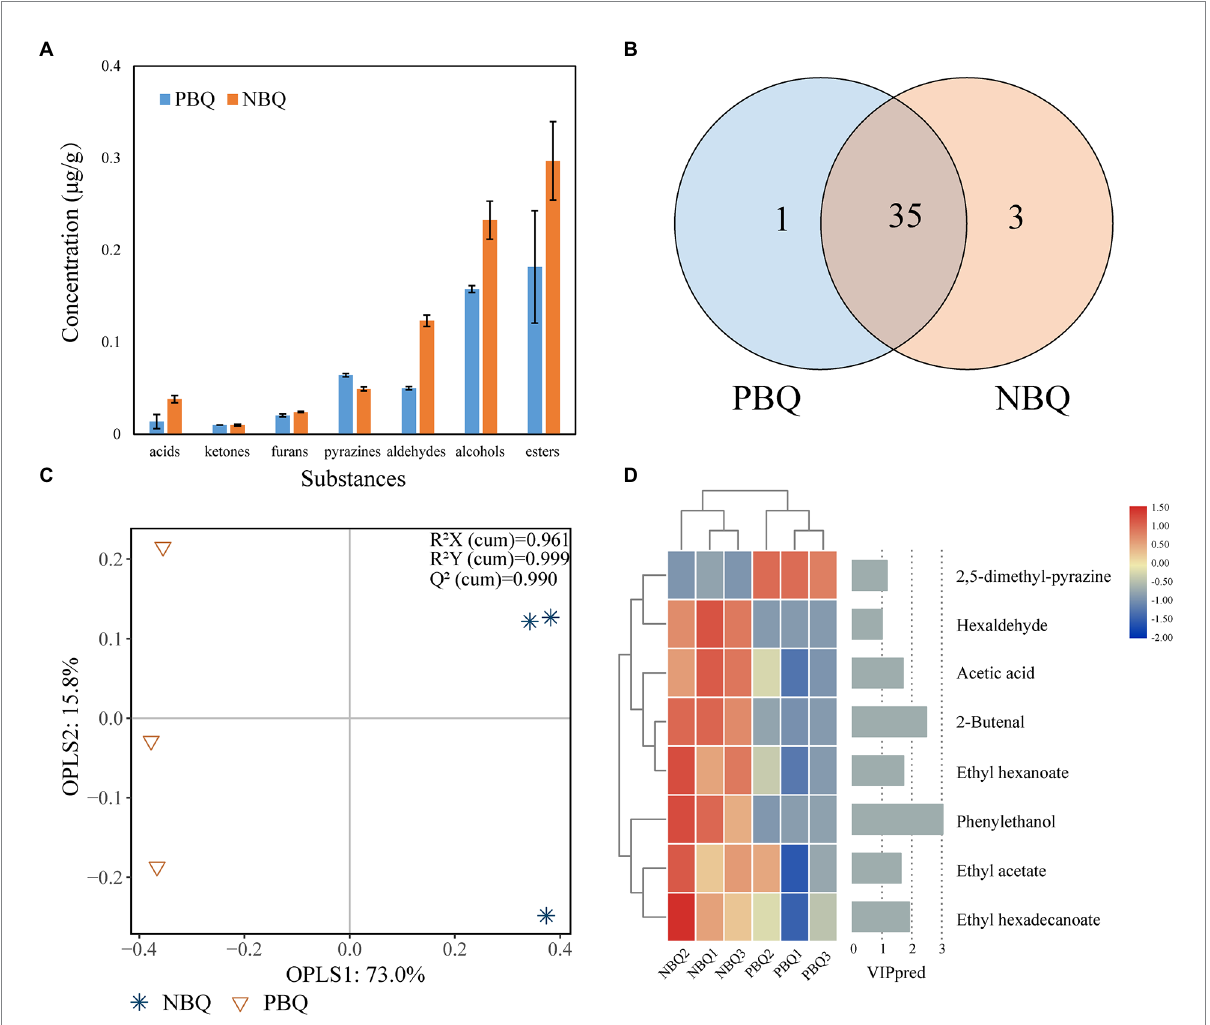
FIGURE 3 The concentration of 7 categories of substances detected in BBQ (A) . Shared and unique volatile substances of PBQ and NBQ (B) . Differential analysis of metabolic composition based on OPLS-DA, R2X ( cum ) = 0.961, R2Y ( cum ) = 0.999, Q2 ( cum ) = 0.990 (C) . Characteristic substance (VIP > 1, calculated by OPLS-DA) contributing significantly to differences between PBQ and NBQ. The left heatmap represents the content of these 8 characteristic metabolites in the two grades of Daqu, while the right histogram represents the VIP value (D)